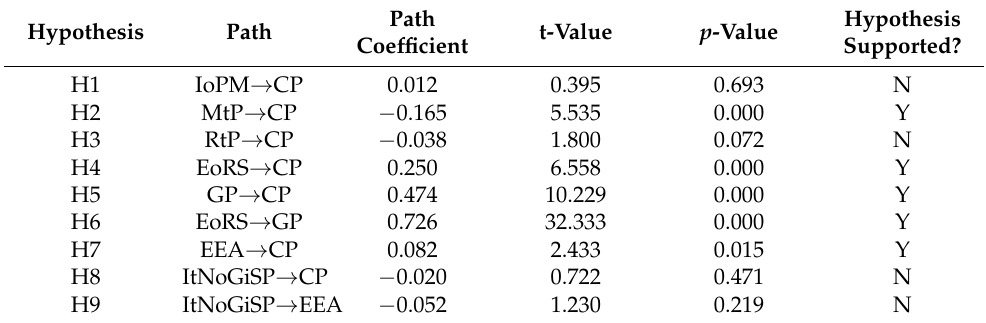
Table 7. Results of hypotheses